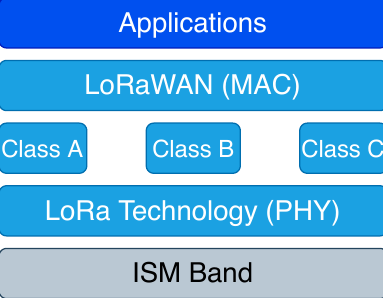
Figure 3. LoRaWAN node network